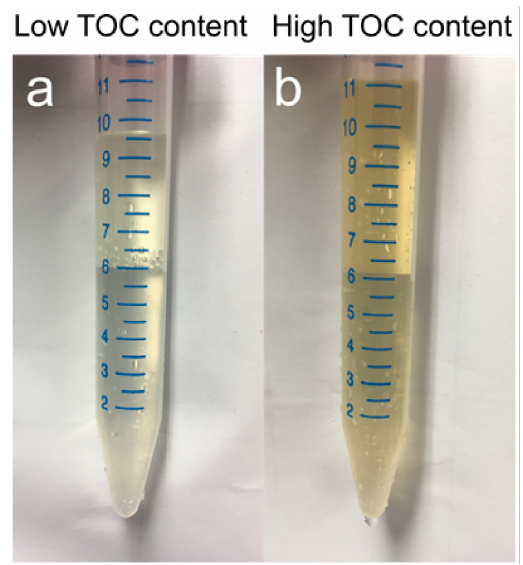
Figure 5. Comparison of two virus extracts derived from two different sediment samples with different total organic carbon (TOC) concentrations. TOC of 0.25% ( a ), estimated TOC 2–4% ( b )